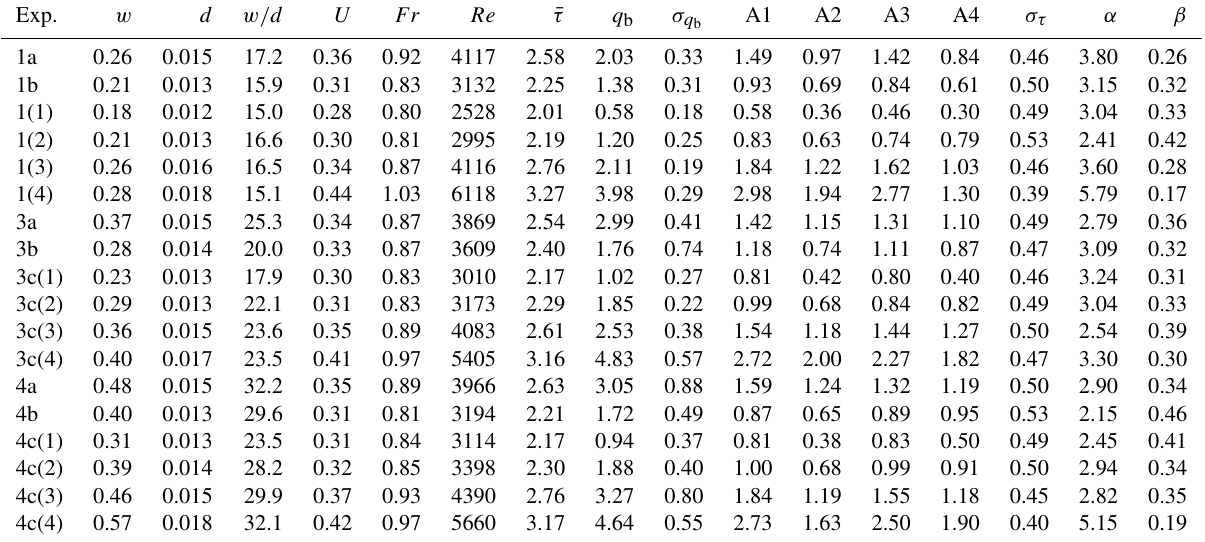
Table 3. Summary of reach-averaged hydraulics (from the 2D flow model) and sediment transport (from measurements). Parameters are as follows. w : wetted width [m], d : flow depth [m], U : velocity [ms − 1 ], Fr : Froude number, Re : Reynolds number ( Ud/v , where v is the kinematic viscosity), ¯ τ : mean shear stress [Pa], q b : unit bedload transport [kgm − 1 min − 1 ]. σ q transport, σ τ is the standard deviation of shear stress, and α and β parameters describe the fitted gamma distribution of shear stress. The parameters A1, A2, B1, and B2 refer to the four approaches outlined in Table 4.